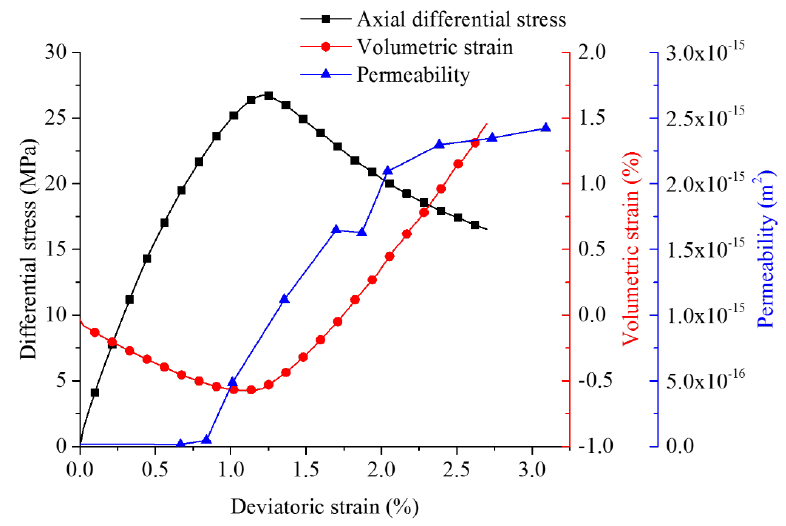
a-1: Differential stress, volumetric strain and permeability evolutions Figure 19. Cont